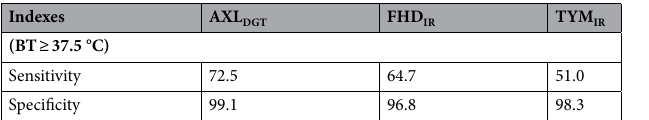
Table 2. Diagnostic accuracy of alternative devices to detect fever compared to mercury thermometer (measurements =